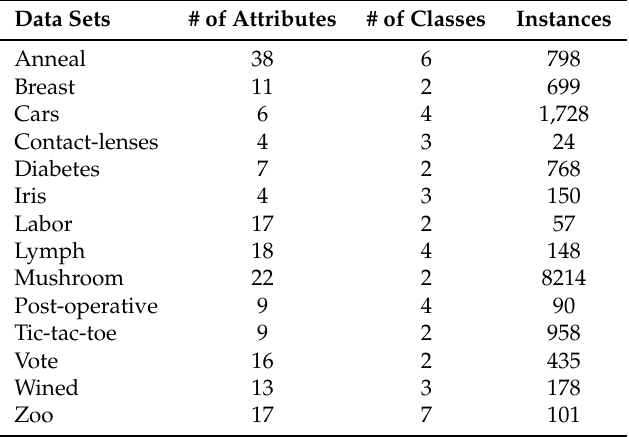
Table 9. Characteristics of the experiment